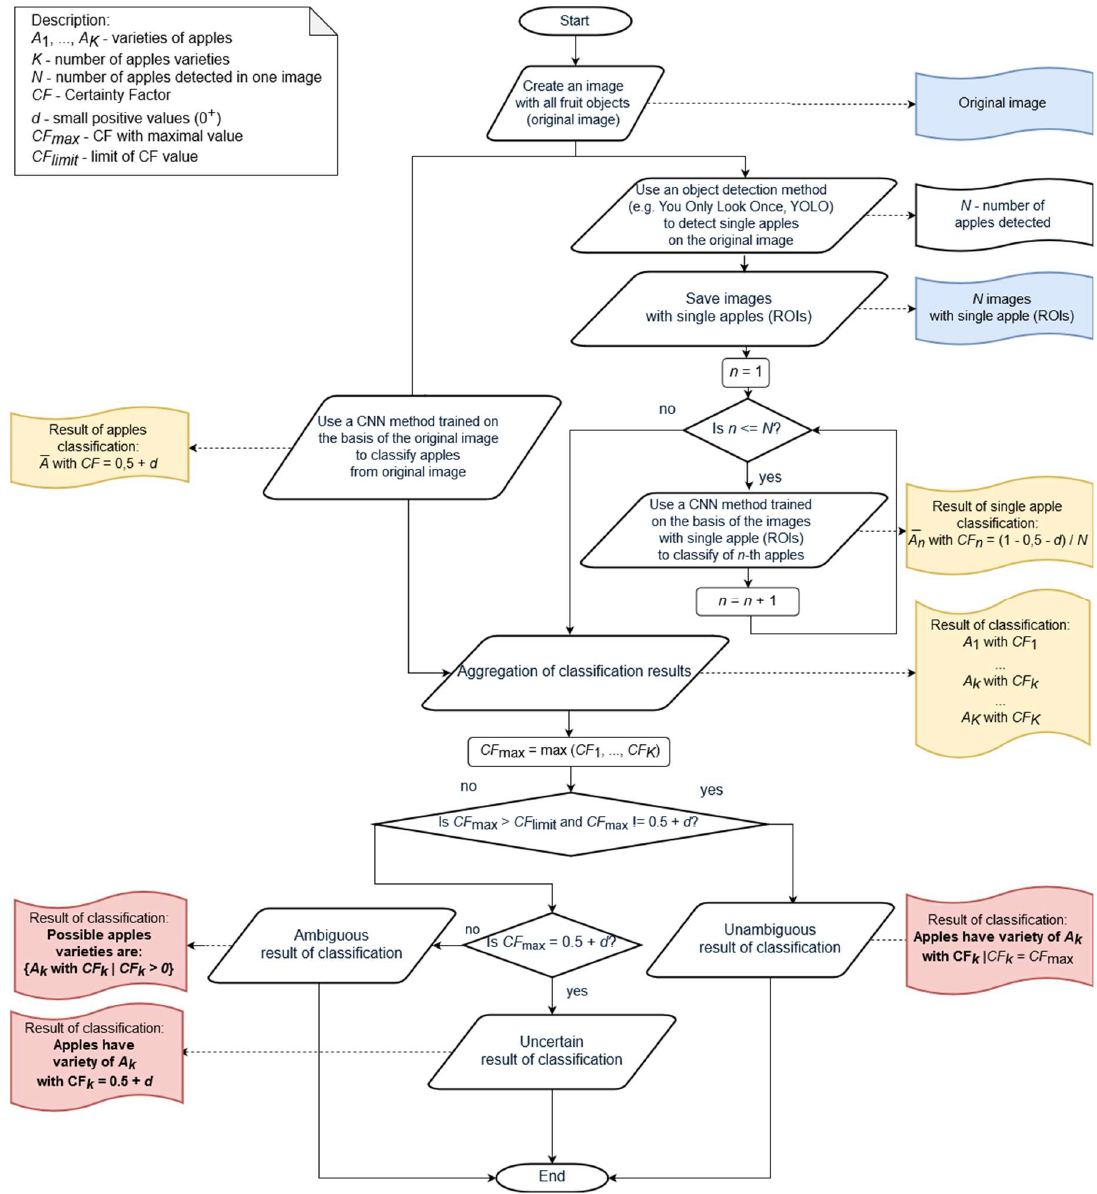
Figure 1. Proposed fruit classification method on an example of apple variety classification.